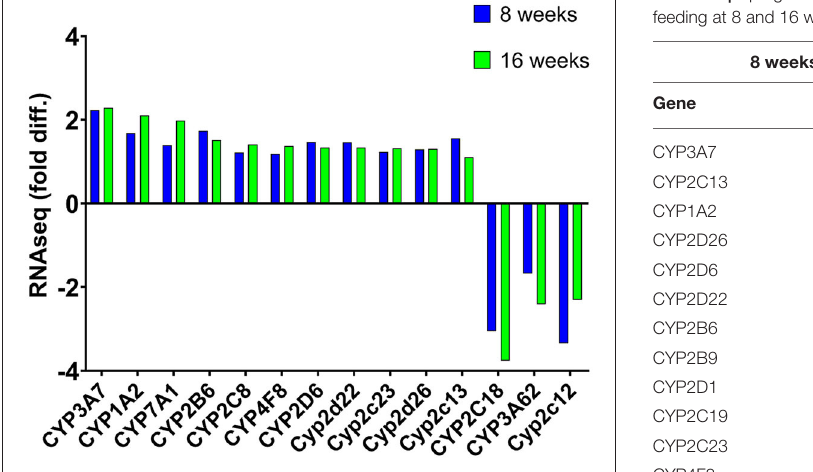
FIGURE 1 | Mean expression (fold difference) of differentially expressed cytochrome P450 (CYP) genes (listed in IPA) that were observed to be expressed at both 8 and 16 weeks in rats fed with the SPI diet compared to those fed with the CAS diet. Positive values indicate upregulation, whereas negative values represent downregulation of these genes. Values represent the mean of 8–10 observations and bars with an asterisk (*) were significant ( P < 0.05). Cyp2c13 was significant after 8 weeks of soy feeding ( p = 4.58 × 10 − 05 ) but not after 16 weeks of soy feeding ( p = 0.24).